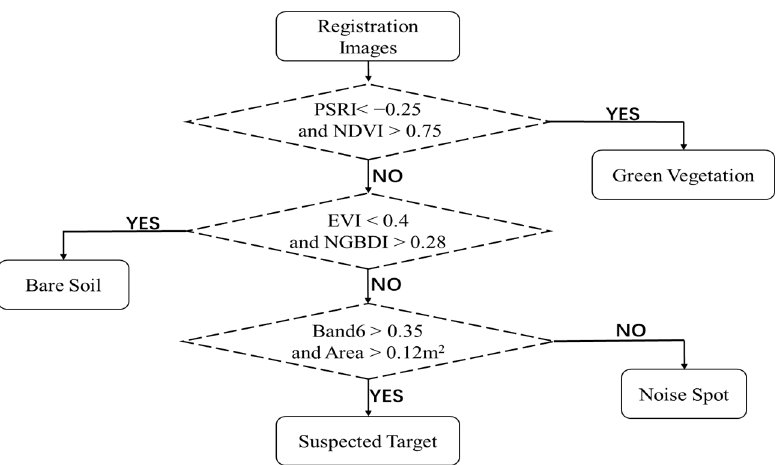
Figure 8. The DT for identification of suspected target.